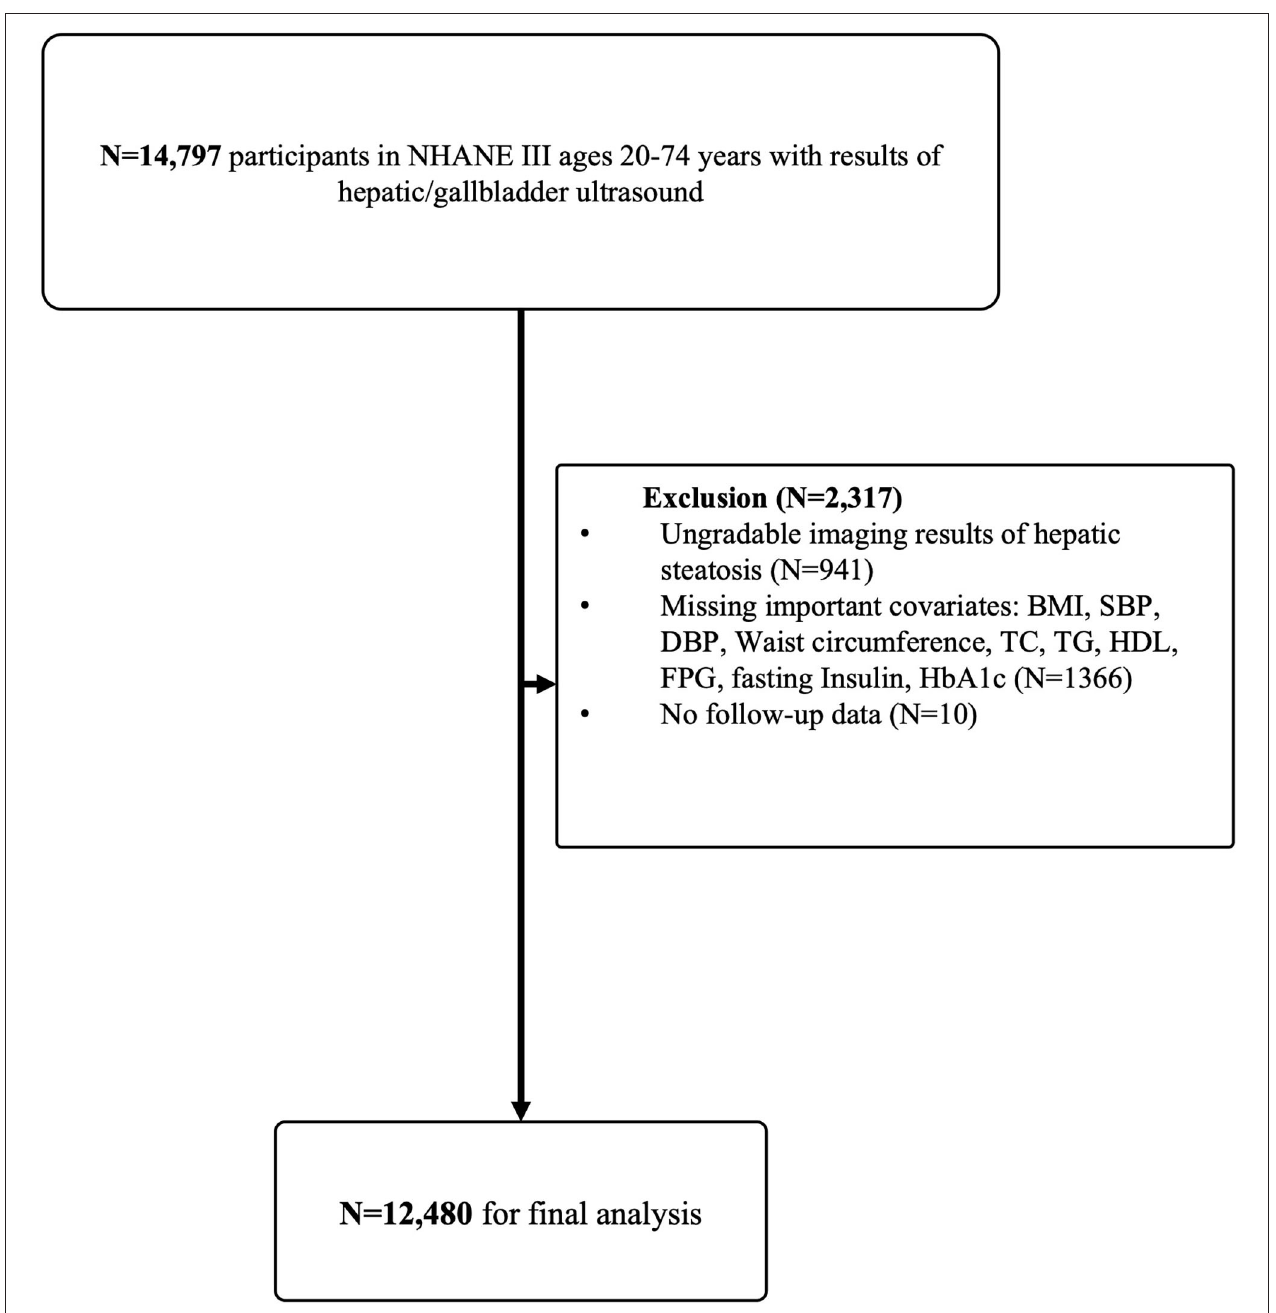
FIGURE 1 | Flow-chart of the Study. NHANE III, The National Health and Nutrition Examination Survey III (1988–1994). BMI, body mass index; SBP, systolic blood pressure; DBP, diastolic blood pressure; TC, total cholesterol; TG, triglyceride; HDL, high-density lipoprotein cholesterol; FPG, fasting plasma glucose; HbA1c, glycosylated hemoglobin.